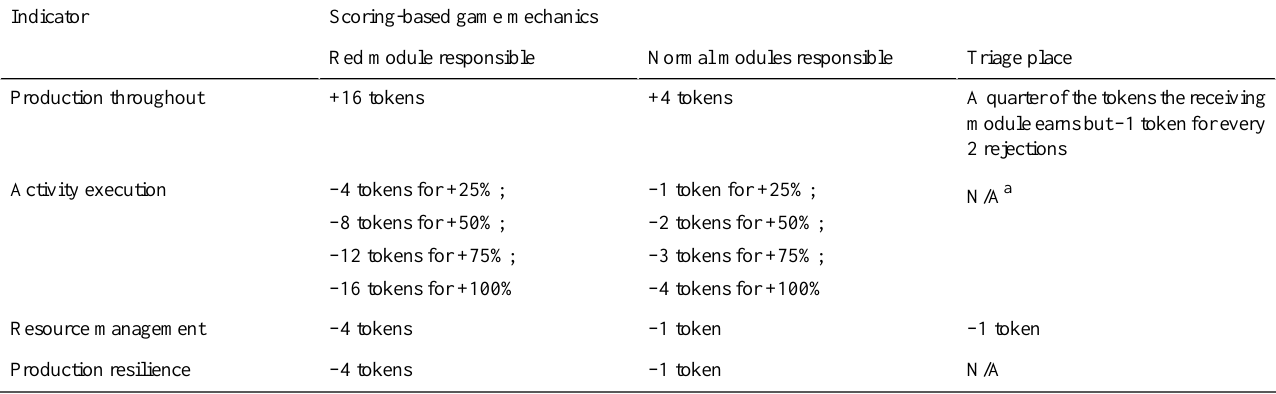
Table 1. Overview of the scoring-based mechanic for corresponding logistical aspects in the pediatric emergency medicine case study.